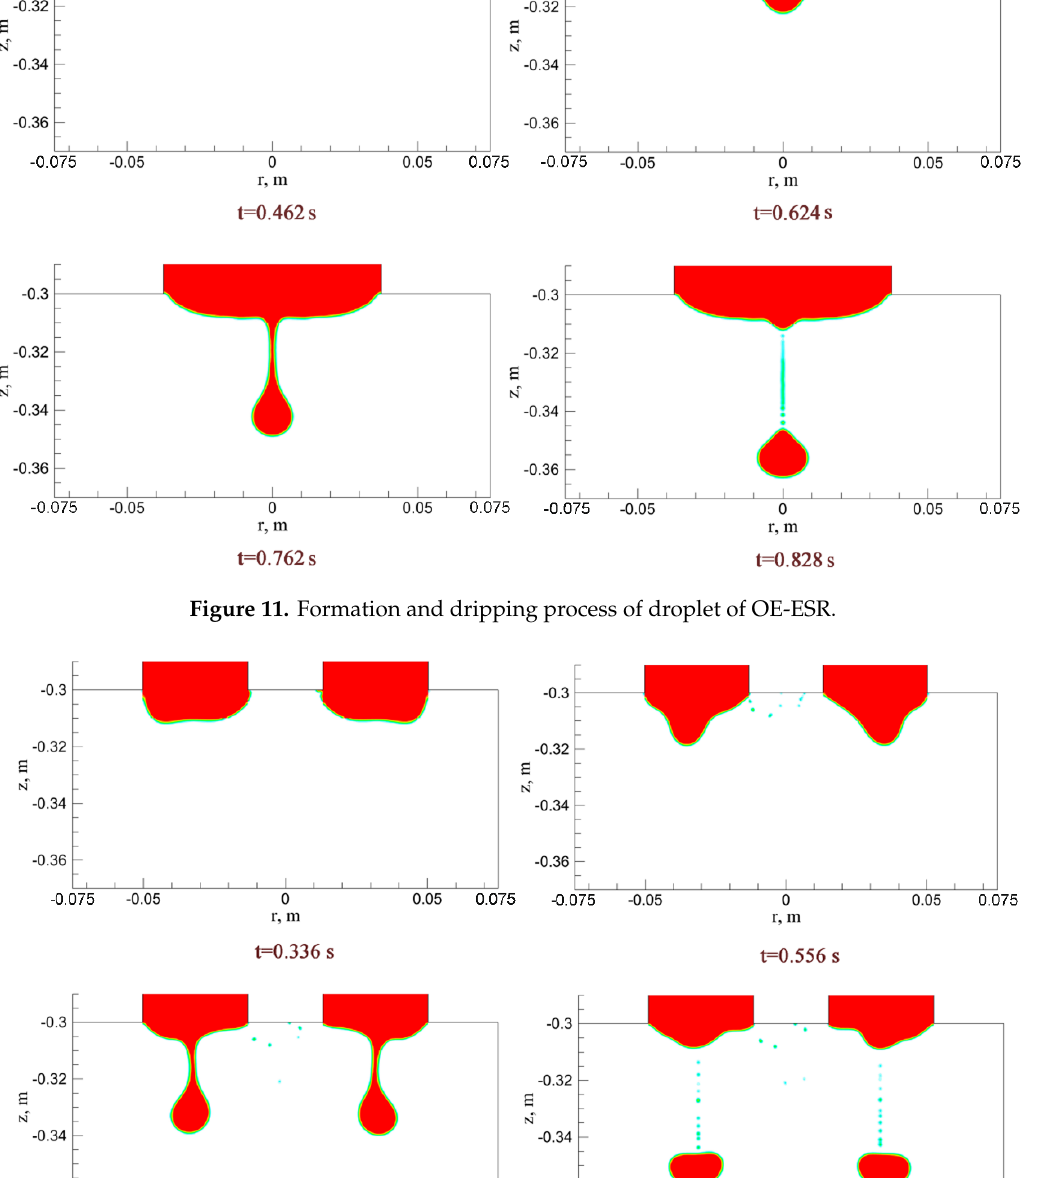
Figure 12. Formation and dripping process of droplet of TSCE-ESR.